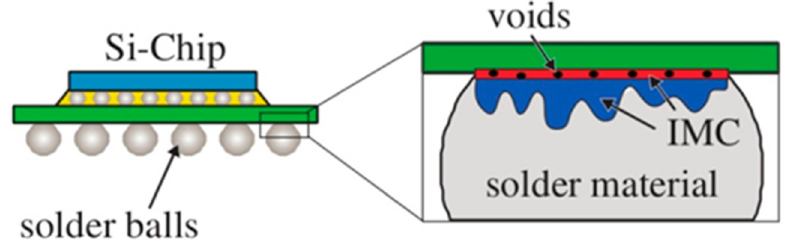
Figure 2. An example of Kirkendall voids in microelectronic packaging [41]. Copyright, 2020, Elsevier.